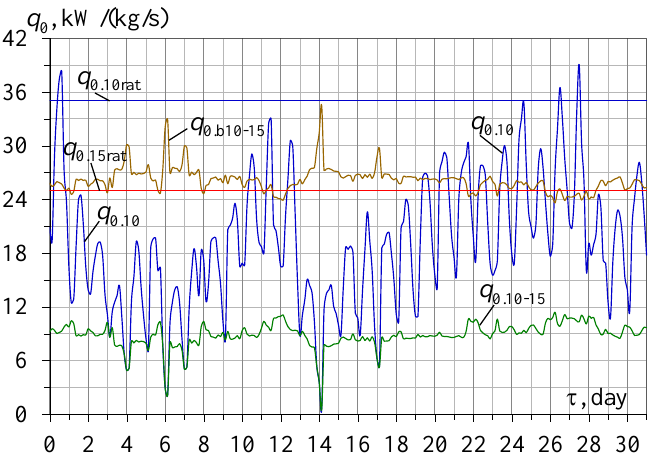
Figure 2. The current values of specific refrigeration capacities q 0.10 required for outdoor air condi- tioning to 10 °C; refrigeration capacities q 0.10-15 for subsequent air conditioning from 15 °C to 10 °C; available booster values q 0.b10-15 remained for outdoor air conditioning to 15 °C: q 0.10-15 = q 0.10 − q 0.15 ; q 0.b10-15 = q 0.10 − q 0.10-15 .